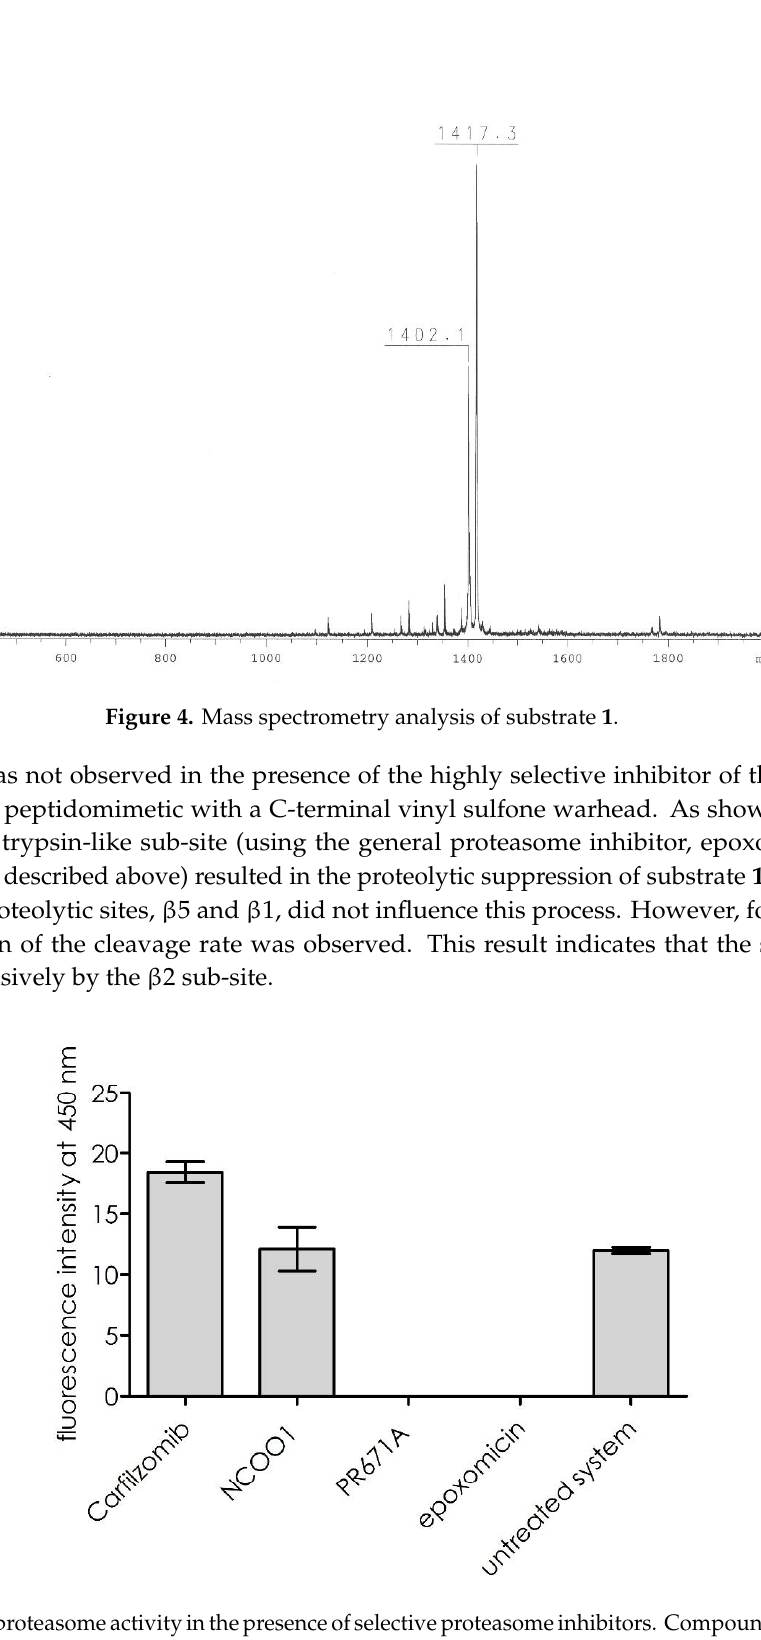
( B ) Figure 6. Kinetic curves for the 20S proteasome in two systems: ( A ) substrate alone and ( B ) in the presence of the artificial activator, 0.01% sodium dodecyl sulfate (SDS).